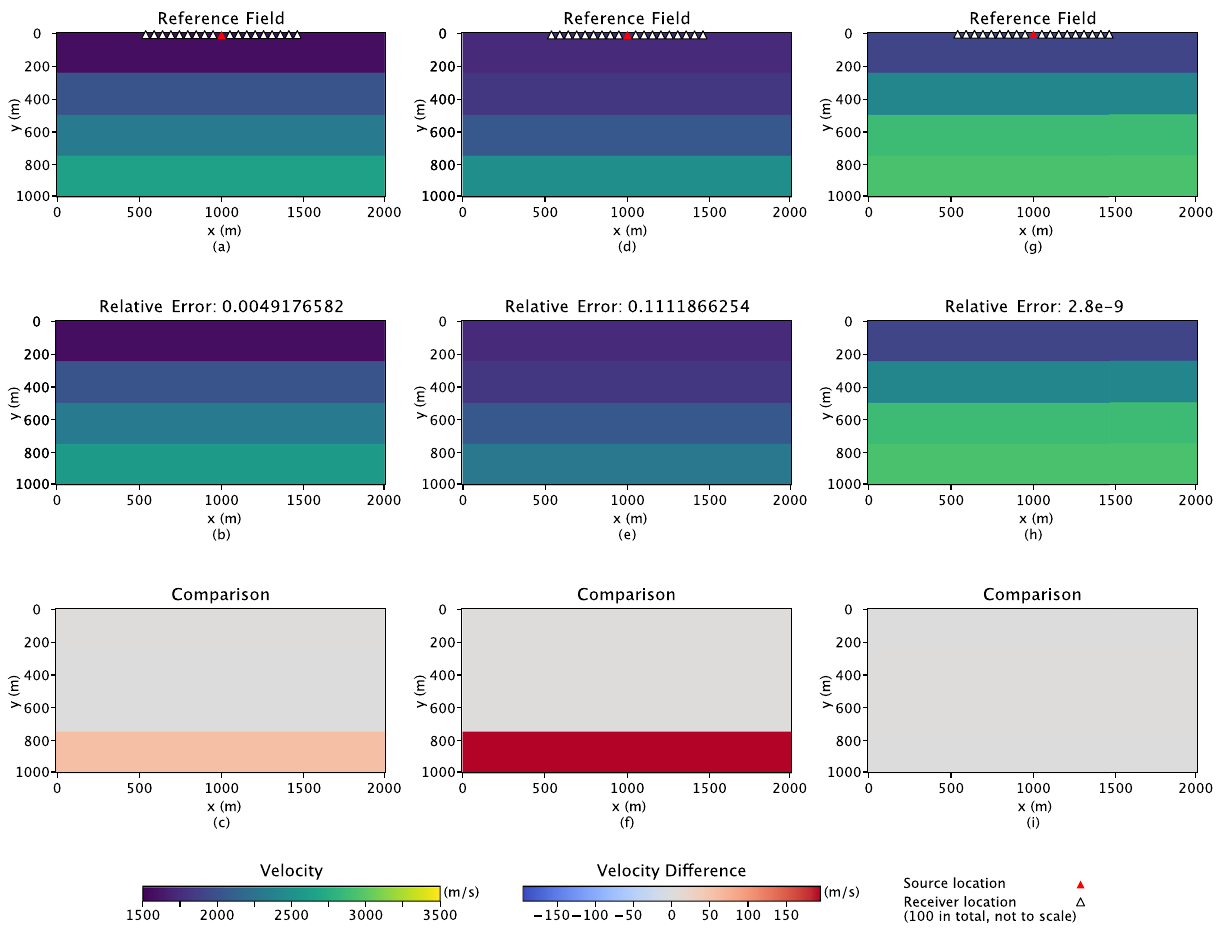
Figure 6. Three reference seismic P-wave velocity fields are shown in subfigures ( a ), ( d ), and ( g ). The red triangle in the first row represents the positions for source location, and the white triangles illustrate the 100 receiver locations, which are not to the real scale. The corresponding inverse results are shown in the second row, subfigures ( b ), ( e ), and ( h ). The relative errors above inverse figures represent the difference between related reference and simulation figures. The last row shows the difference between the related reference fields and the inverse